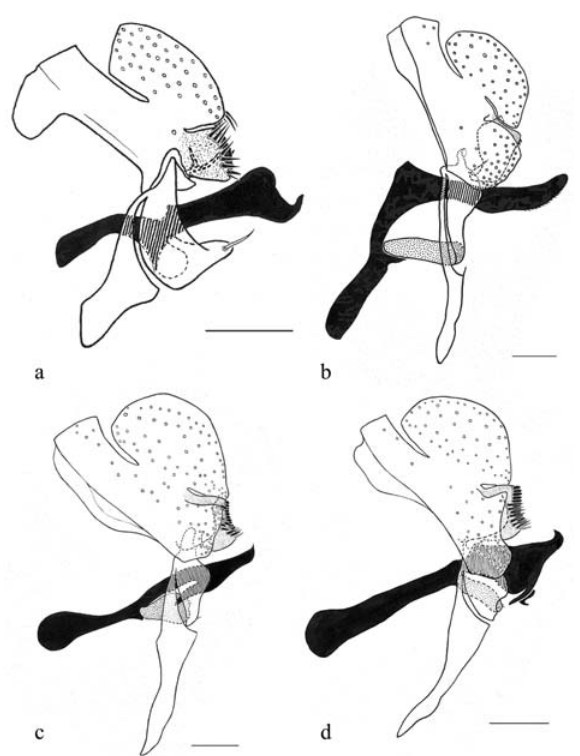
Figure 6 - Male terminalia (aedeagus + aedeagal apodeme are highlighted in black, and paraphysis is highlighted with dots), left lateral view, of: a. Drosophila neocardini Streisinger, 1946; specimen from Rio Negro, State of Amazonas, Brazil. b. Drosophila coffeata Williston, 1896; specimen from Vila Atlântica, Mongaguá, State of São Paulo, Brazil. c. Drosophila camargoi Dobzhansky & Pavan, in: Pavan 1950; specimen from Panama, most probably no.15, (strain H80.5b [University of Texas]). d. Drosophila dreyfusi Dobzhansky & Pavan, 1943; locality unknown. Scale bars = 0.1 mm.